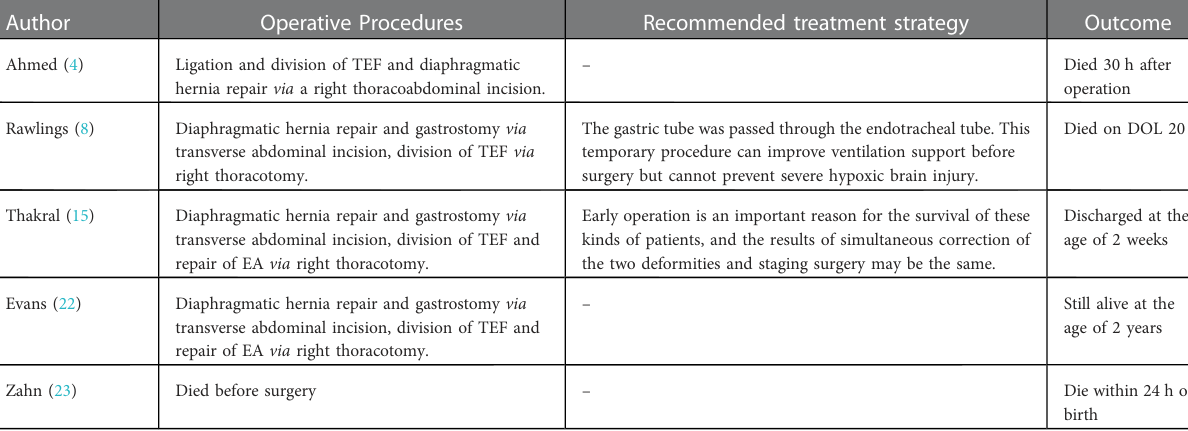
TABLE 3 Summary of treatments of right CDH associated with EA or EA and TEF.